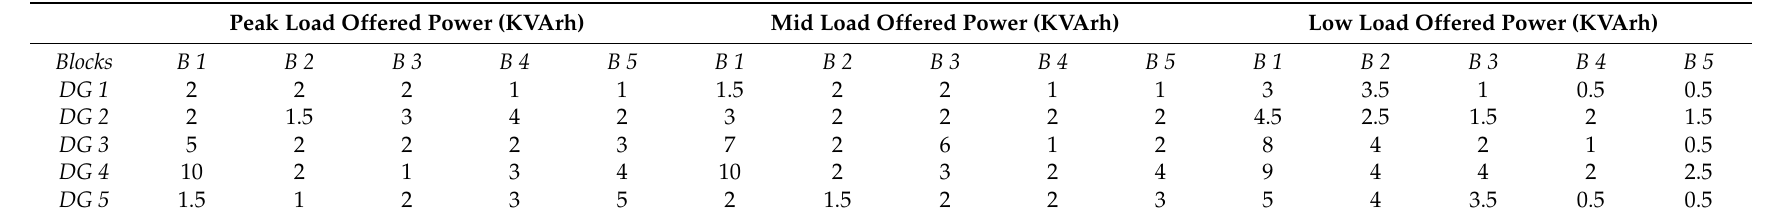
Table 5. Data of DGs’ offered reactive power